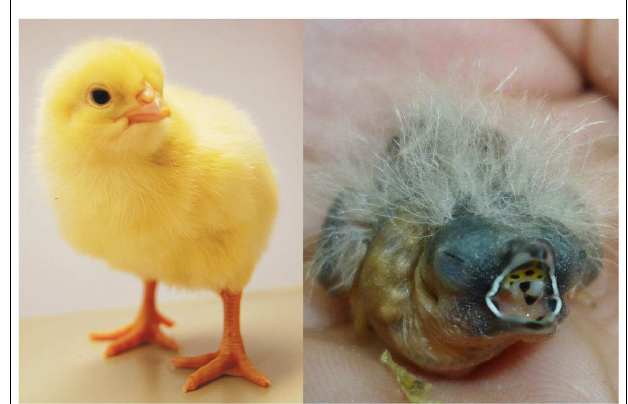
FIGURE 2 | Bird species with different developmental modes: the precocial chicken ( Gallus gallus ), 1 day old, and the altricial zebra finch ( Taeniopygia guttata ), 3days old . Photographs by Sylvia Grommen (chicken) and Nicola Khan (zebra